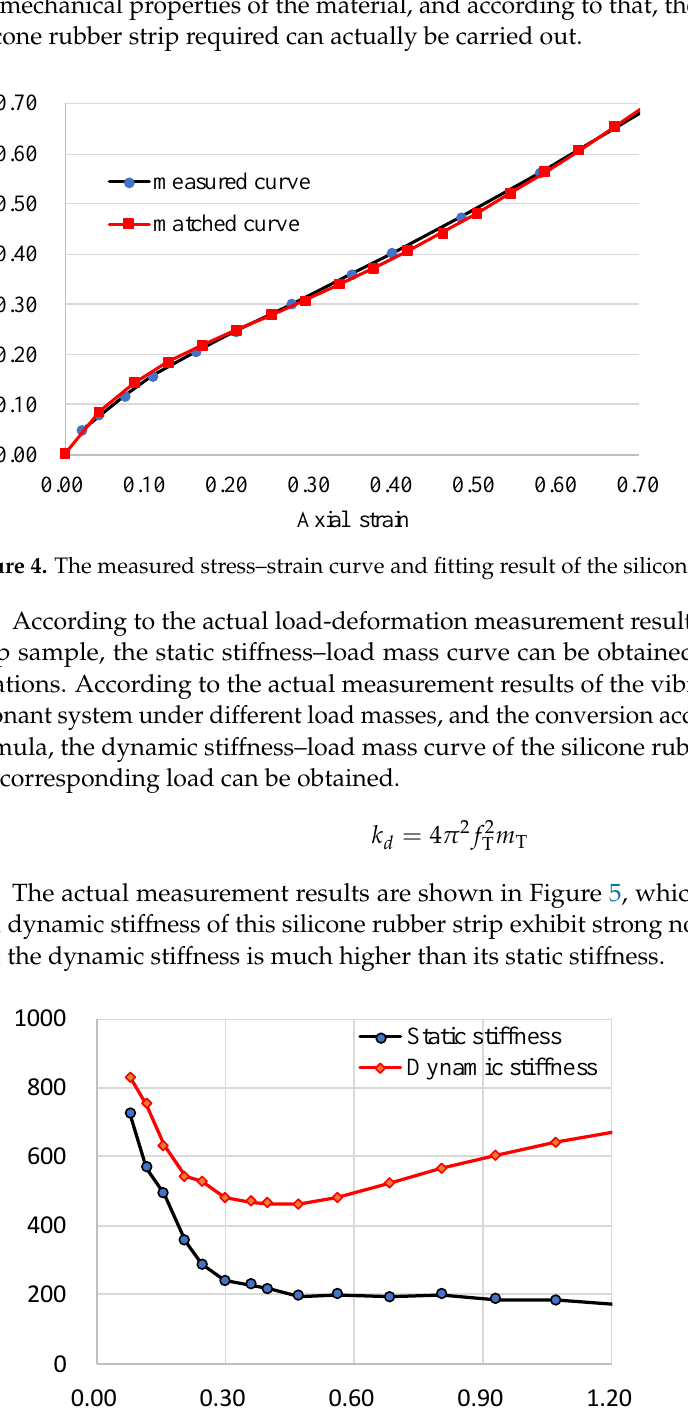
Figure 6. The equivalent static Young’s modulus and dynamic Young’s modulus of a silicone rubber strip under different stress states. 3.3. Design and Performance Analysis of Vibration Damping System for Silicone Rubber Strip For the antenna damping system composed of four silicone rubber strips, as shown in Figure 2, the length and cross-sectional area of the silicone rubber strip in the static equilibrium state are respectively l and s, and the angle between itself and the vertical longitudinal section is θ . In addition, the tensile stress of each silicone rubber strip is σ , and the relationship between itself and the antenna mass m is as follows: max cos mg s 